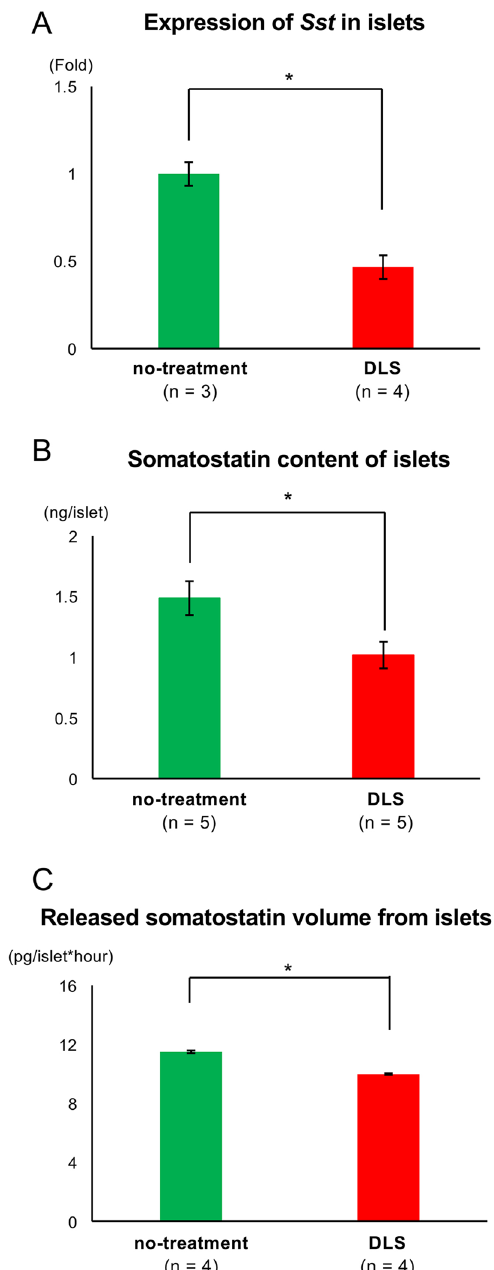
Figure 3. Therapeutic effect of the GHS-R1a antagonist in somatostatin-releasing function. ( A ) Expression of Sst in islets in the no-treatment and DLS groups. Gene expression was quantified using real-time RT-PCR with Actb as the internal control. ( B ) Somatostatin content of islets in the no-treatment and DLS groups. ( C ) Somatostatin volume released from islets in the culture medium for 24 h. Data are presented as means ± SEMs. P value of < 0.05 was considered statistically significant; * p <